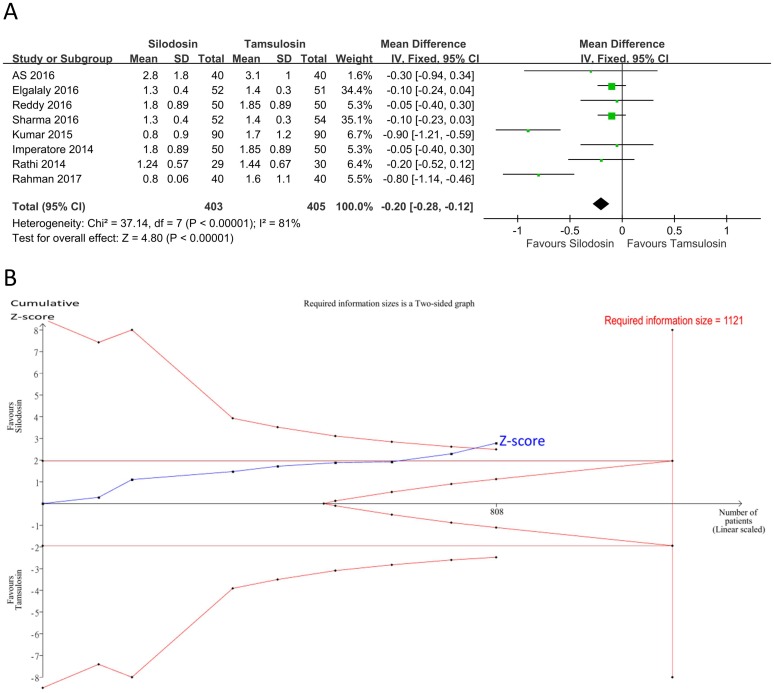
Forest plot and trial sequential analysis for pain episodes.A: Forest plot. MD, mean difference; CI, confidence interval. B: Trial sequential analysis of the effect of silodosin on pain episodes compared to tamsulosin. The risk of a type 1 error was maintained at 5% with a power of 90%. The variance was calculated from the data obtained from the included trials. A clinically significant anticipated mean difference in the expulsion time was set to 0.3 episodes based on the pooled result of our meta-analysis. The result showed that firm evidence indicated that silodosin had fewer pain episodes compared to tamsulosin.